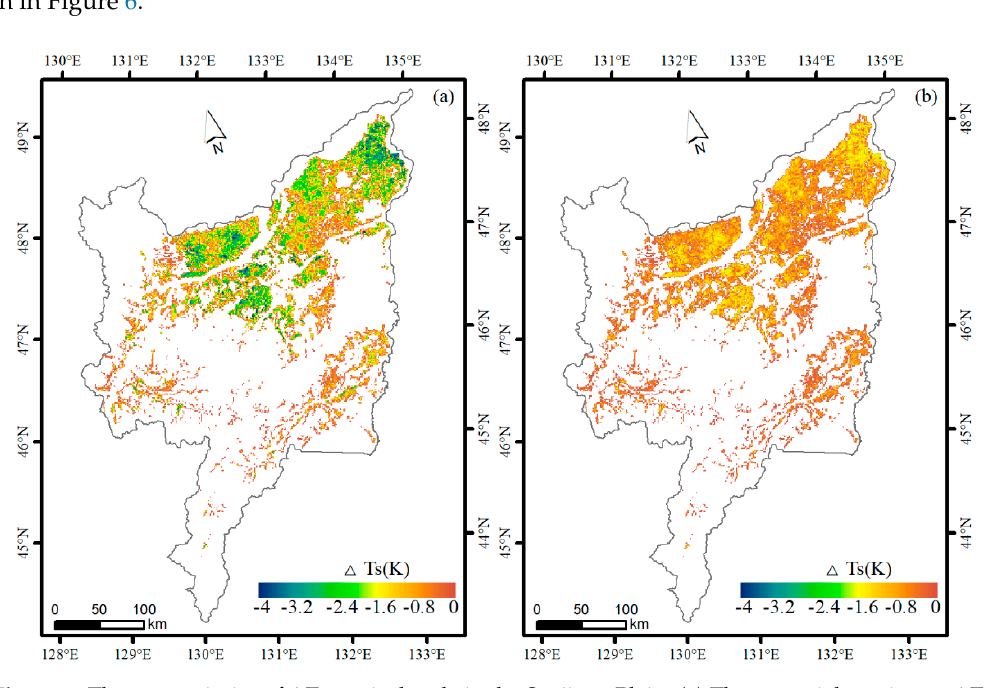
Figure 6. The uncertainties of ∆ T s at pixel scale in the Sanjiang Plain. ( a ) The potential maximum ∆ T s when we assumed all the paddy field expansion from rain-fed farmland occurred in 2006, and ( b ) the potential minimum ∆ T s when we assumed the expansion occurred in 2015.